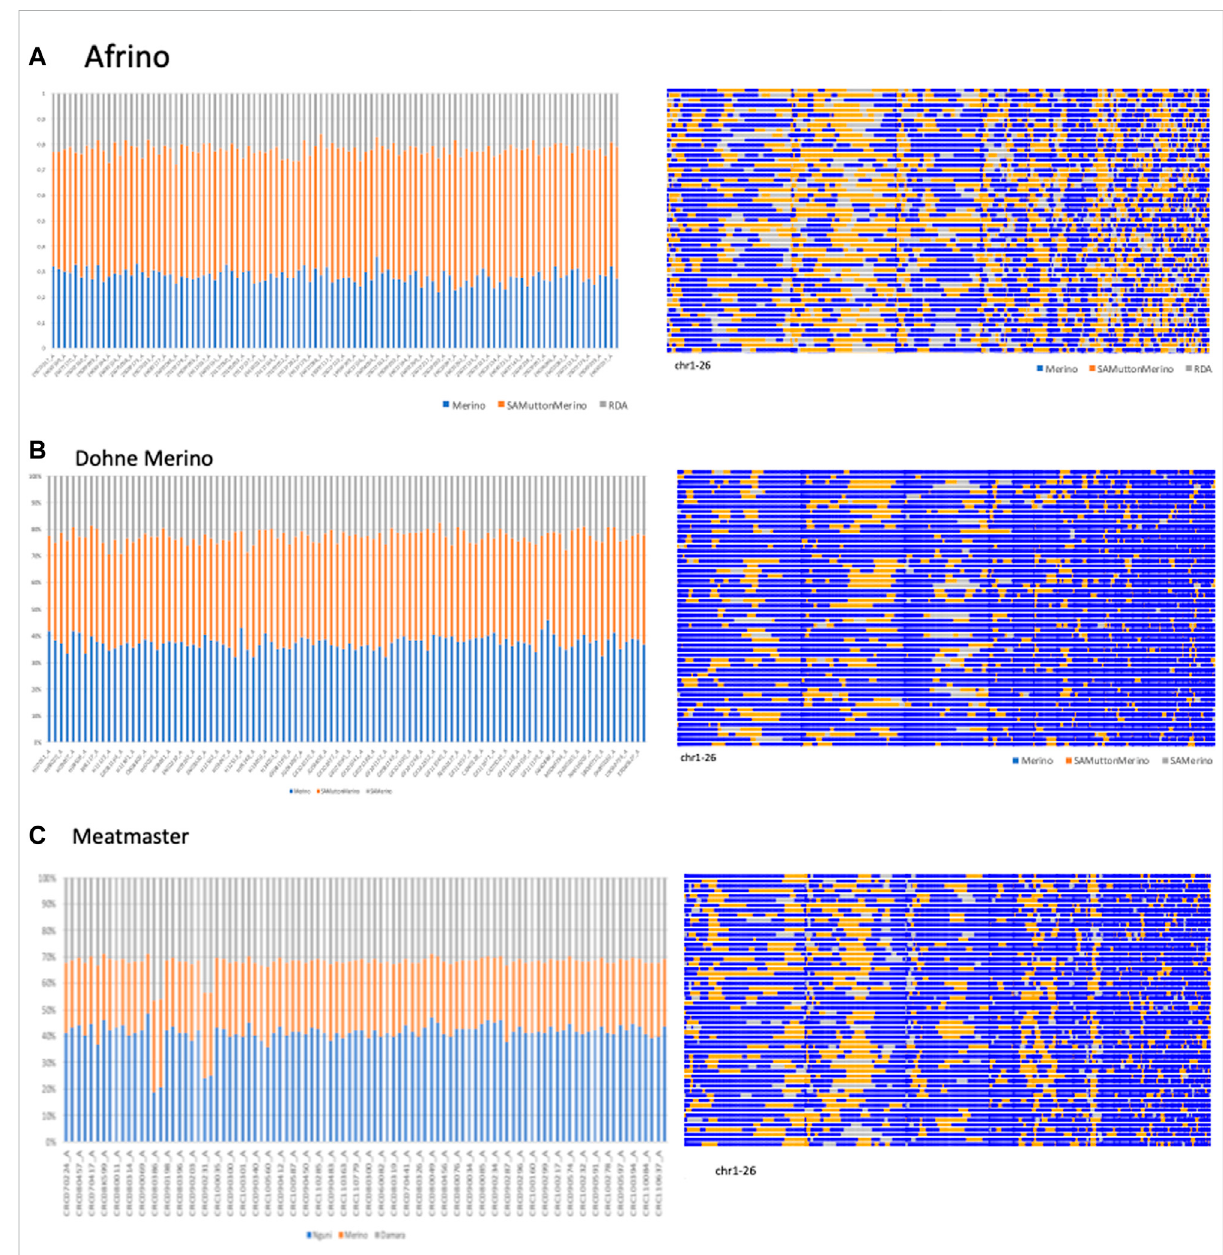
FIGURE 2 PCAmix of Merino-derived breeds [Afrino, (A) ; Dohne Merino, (B) ; and Meatmaster, (C) ] and their presumed